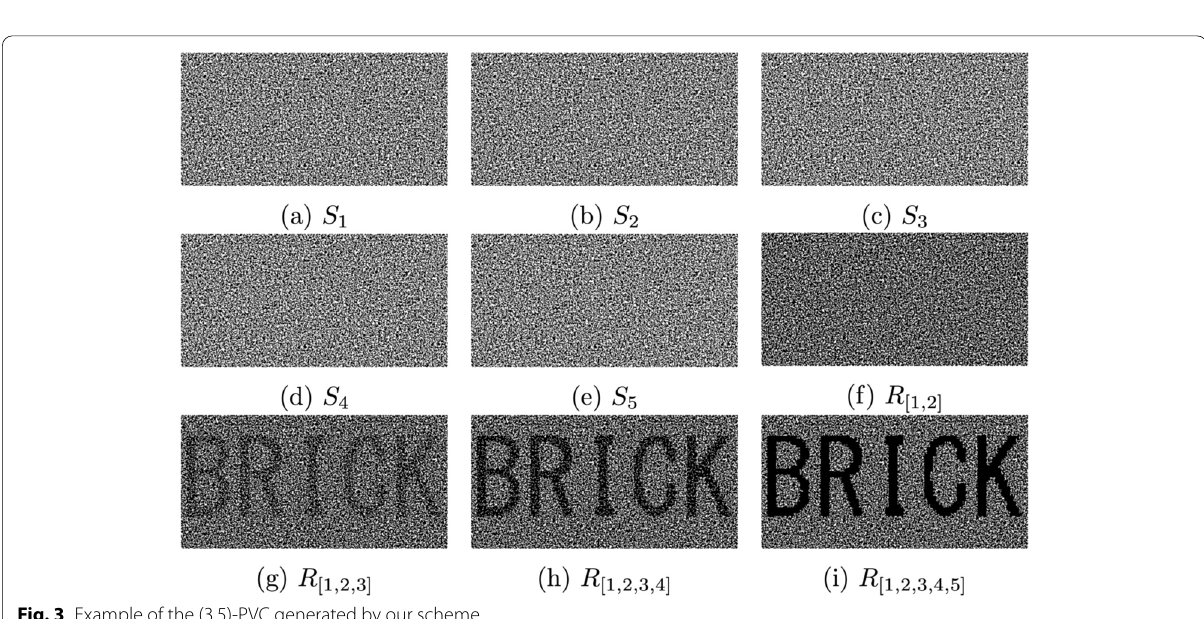
Fig. 2 Example of the (3,5)-PVC generated by the basic scheme